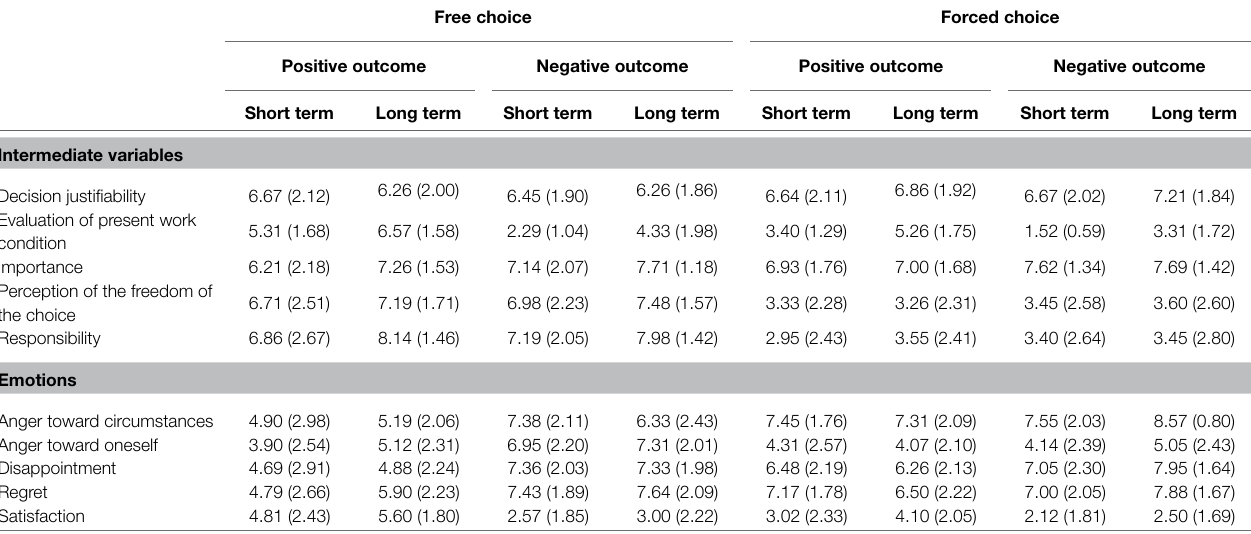
TABLE 1 | Study 1 – means and standard deviations (S.D.) of intermediate variables and emotions as a function of choice, outcome, and